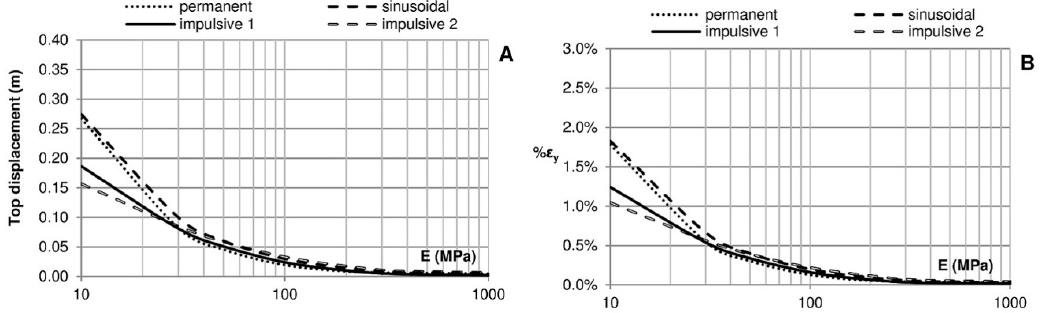
Figure 8. ( A ) Movement on the top of the crown wall; ( B ) maximum vertical deformation of the foundation.